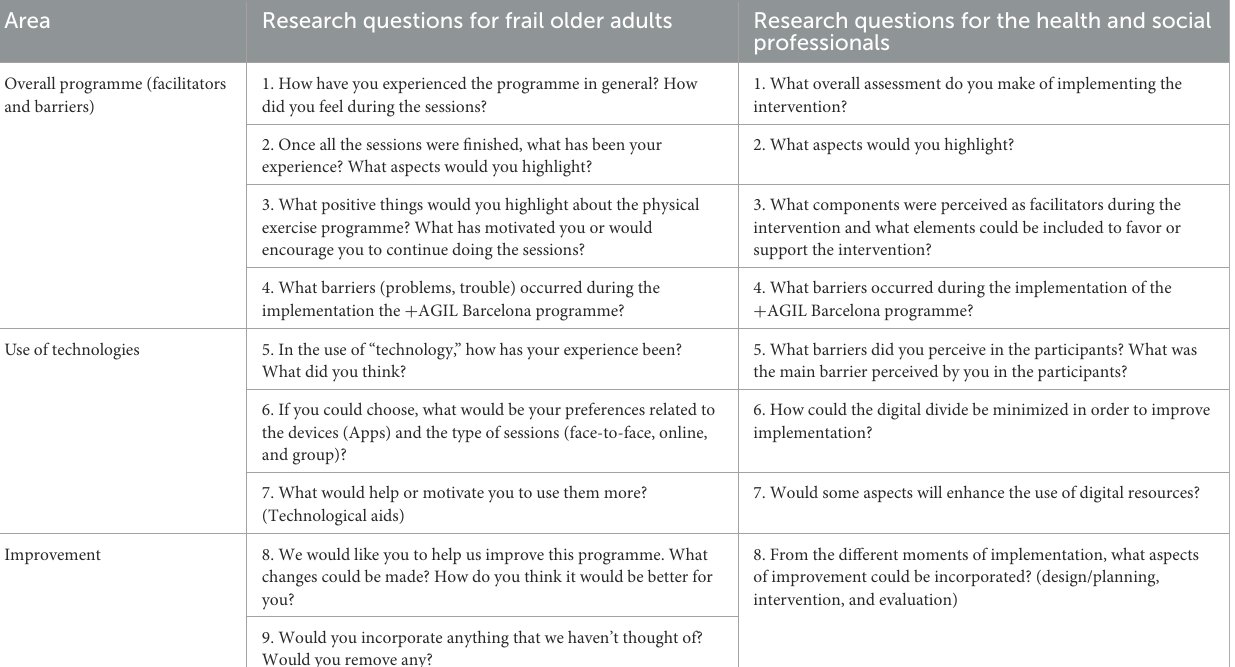
TABLE 1 Research